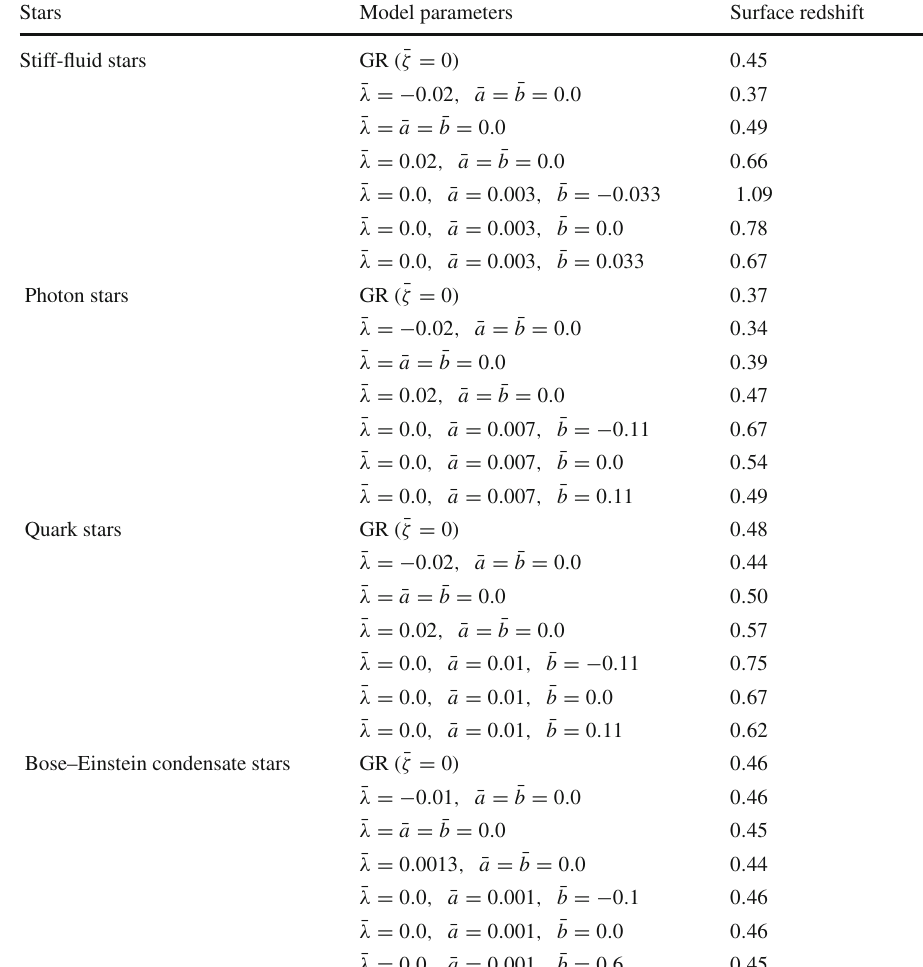
Table 9 The surface redshift of different types of three-form field stars with maximum mass, for different model